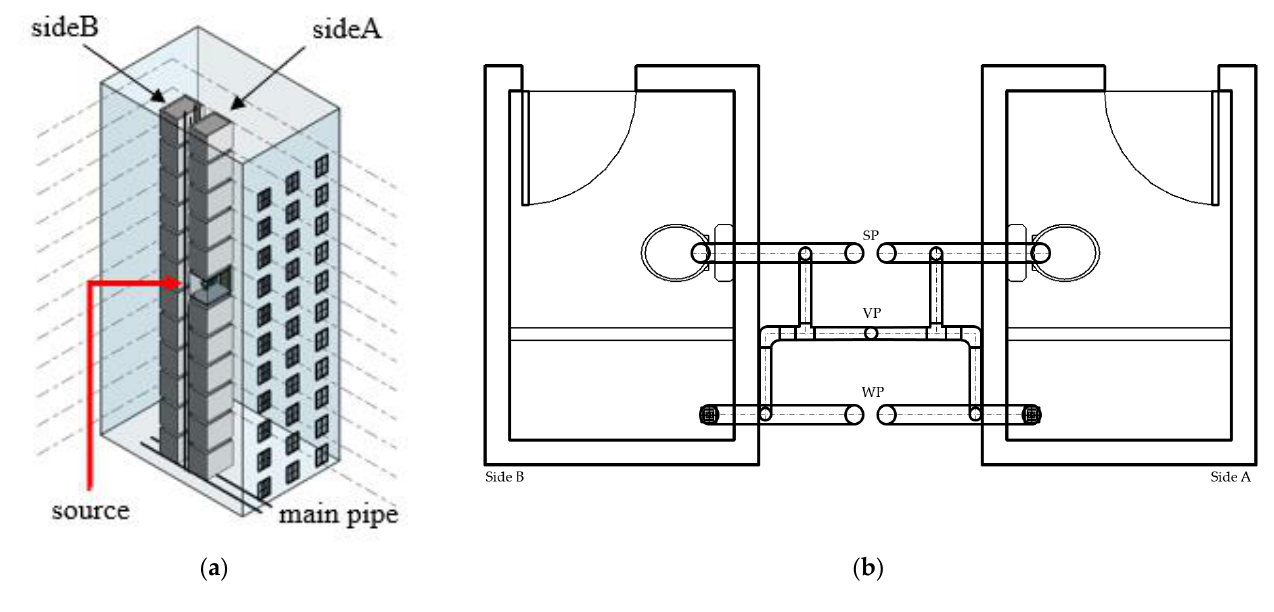
Figure 5. Simulation model design. ( a ) System overlook. ( b ) Scenario of two bathroom units.